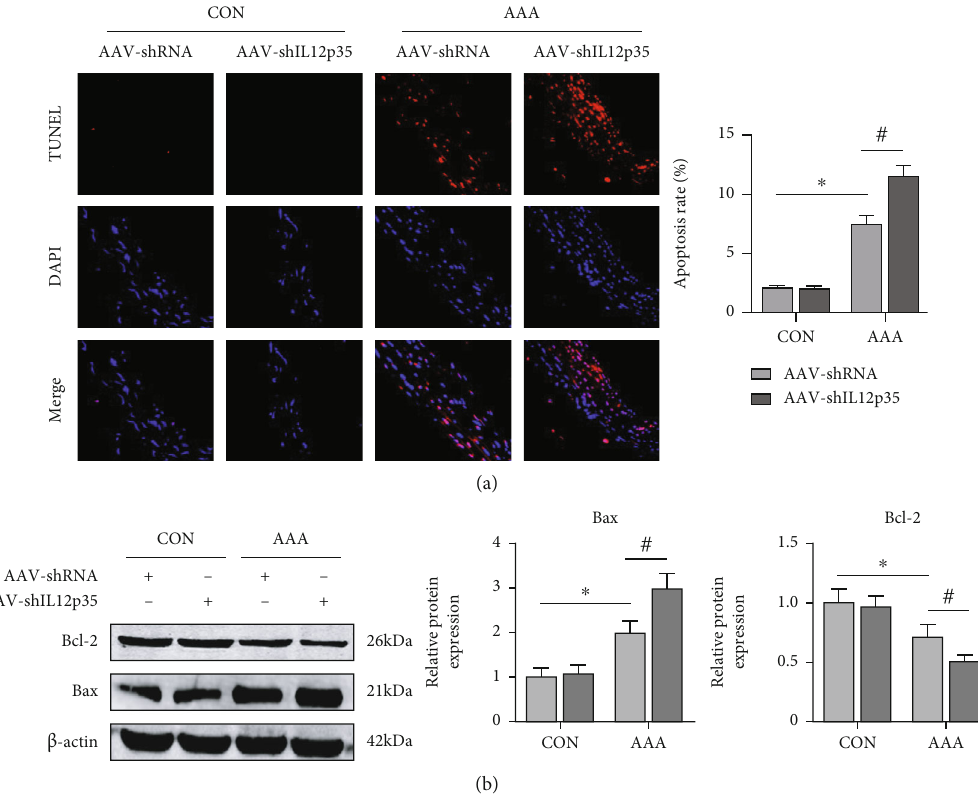
Figure 4: IL12p35 silencing exacerbates SMC apoptosis after Ang II infusion. (a) Representative TUNEL staining in the four groups of mice ( n = 8 per group). (b) Western blot analysis of the protein levels of Bcl-2 and Bax in the aortas of the four groups ( n = 5 per group). ∗ P < 0 : 05 compared with the control group; # P < 0 : 05 compared with the AAA